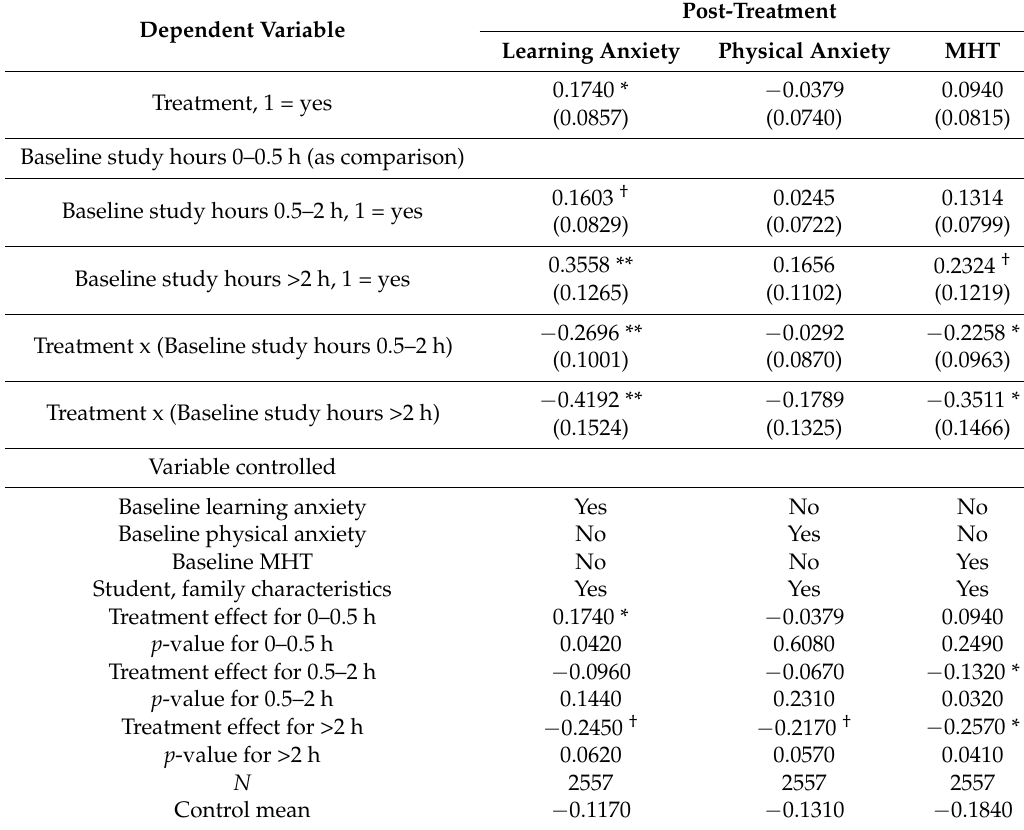
Table 3. Impact of Subsidized Eyeglasses on Mental Health by After-class Study